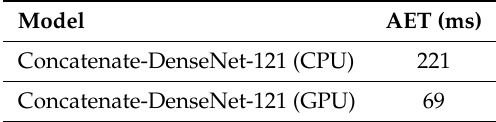
Table 7. The average execution time (AET) of the proposed